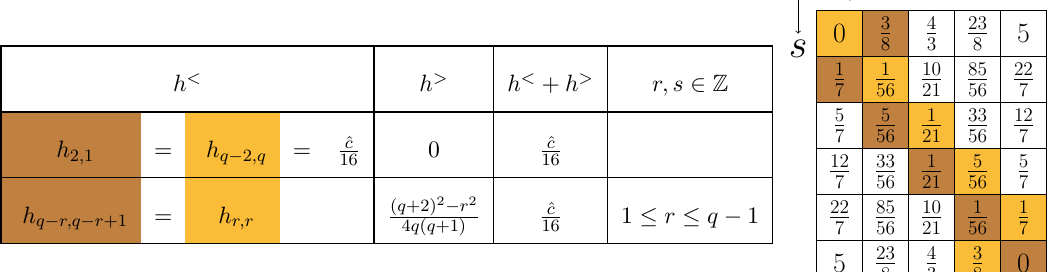
(cid:0) 3 (cid:1) ; 2 for ^ c = 4( q + 3) =q , q (cid:21) 3. As a visual guide, we 2